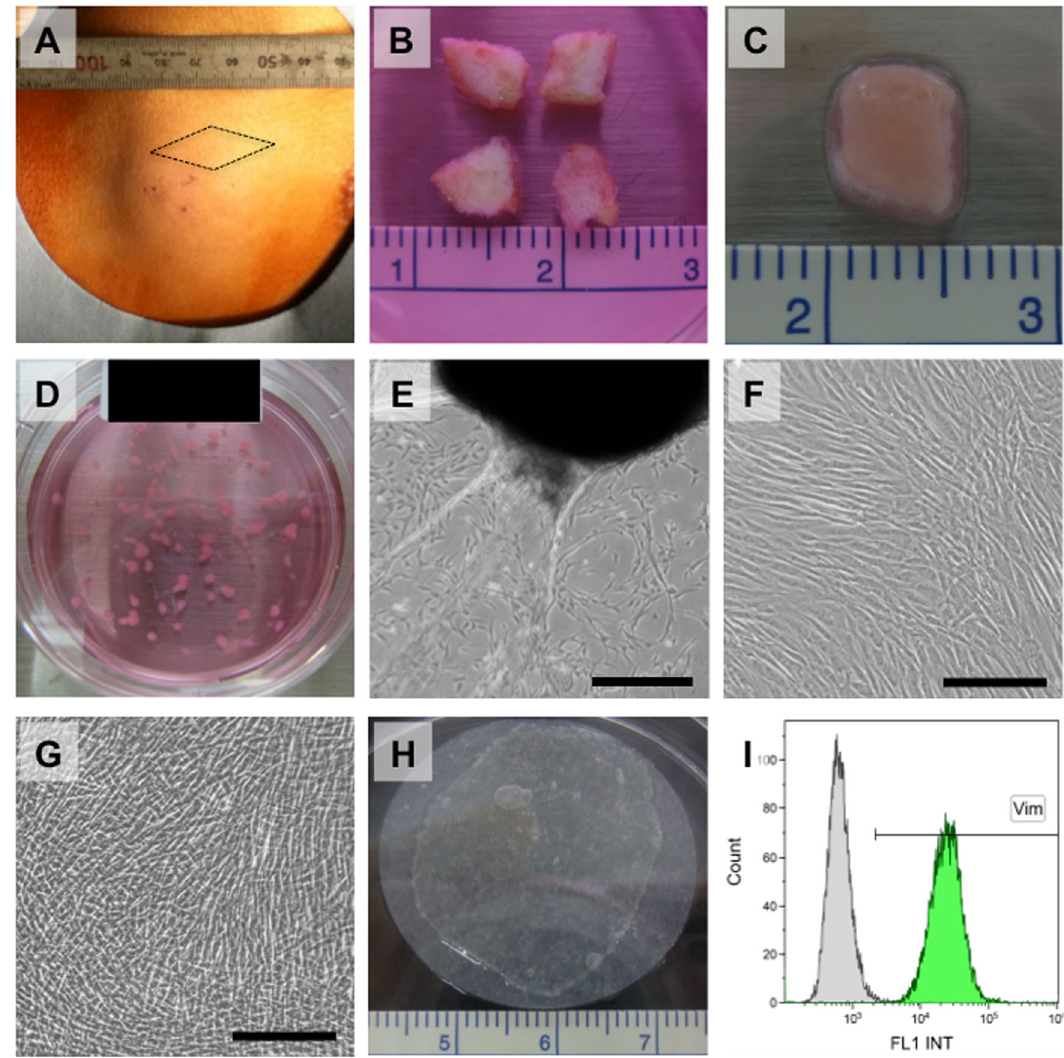
Fig. 1 Preparation of autologous dermal fi broblast sheet. A Skin was excised from the planned surgical location of the skin incision from the lateral chest under local anesthesia. B A 5-mm square of tissue was prepared using dissecting scissors. C A 5-mm square of tissue underwent enzymatic treatment in a culture dish in a carbon dioxide gas incubator for 2 – 3 h. D The 1-mm square tissue pieces were transferred into a 60-mm dish for primary culture. E Phase-contrast micrographs of fi broblasts that migrated from transferred tissue pieces after 17 days in explant culture. Scale bar indicates 500 µm. F Phase-contrast micrograph of fi broblasts at 4 days after subculture on a 100-mm culture dish. Fibroblasts proliferated to form monolayers. Scale bar indicates 200 µm. G Phase-contrast micrograph of fi broblasts at 10